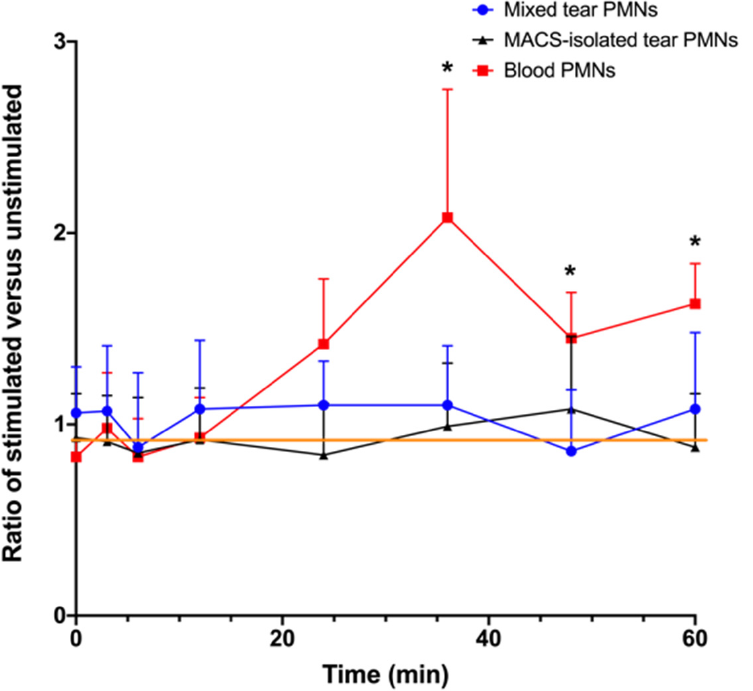
Figure 2. Changes in chemiluminescence (CL) of LPS-stimulated PMNs. Results are reported as ratio of LPS-stimulated PMNs CL emissions over control (unstimulated PMNs) CL emissions. A total of 50,000 cells were transferred to wells containing 1 mM luminol and HBSS followed by the addition of 2 μ g/mL LPS. Generation of ROS was measured over time using the Cytation 5 at 37 °C. The orange line indicates a ratio of 1, meaning no difference between stimulated and unstimulated CL values. Values are presented as means ± standard deviations; mixed tear PMNs (n = 10–12 from 10 participants), MACS-isolated tear PMNs (n = 6 from 6 participants), and blood PMNs (n = 5 from 4 participants). * Significantly different from mixed and MACS-isolated tear PMNs ( p ≤ 0.037). Table 1. Absolute and relative ROS production in unstimulated and LPS-stimulated PMNs, as measured by AUC.